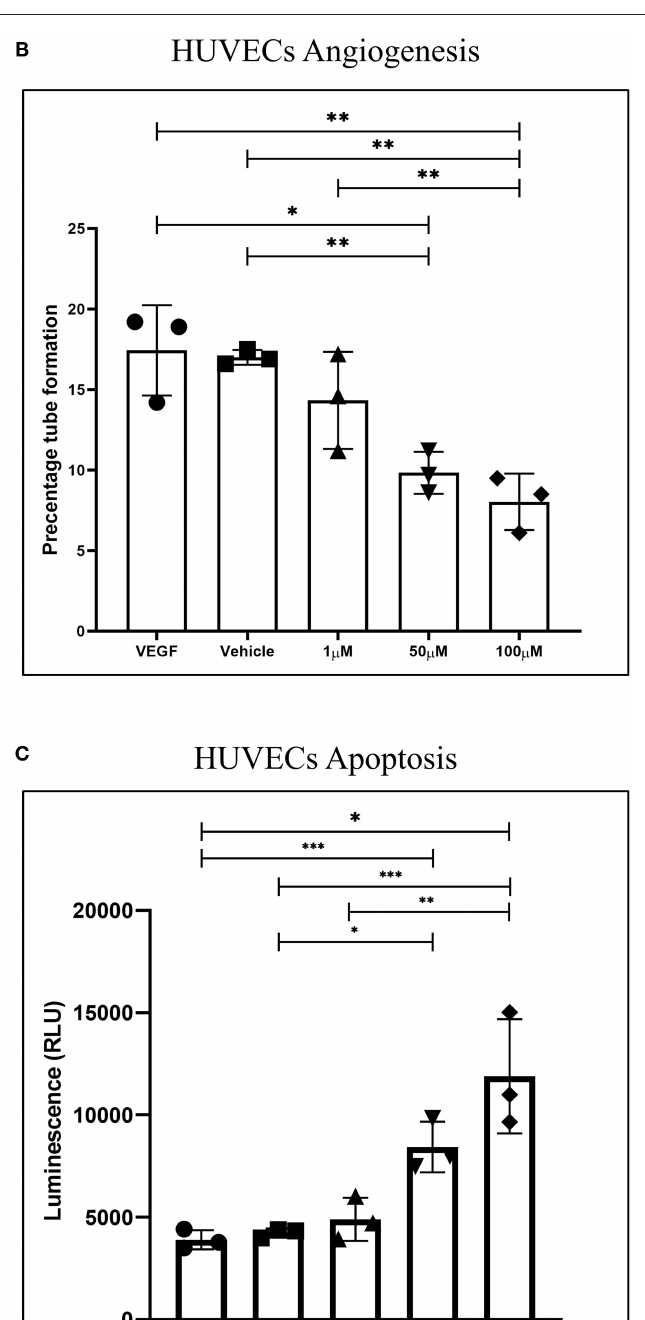
( Supplementary Figure 3 ). Analysis of peritoneal immune cell populations on days 14 and 28 did not show any significant differences in general immune cell types categorized as the